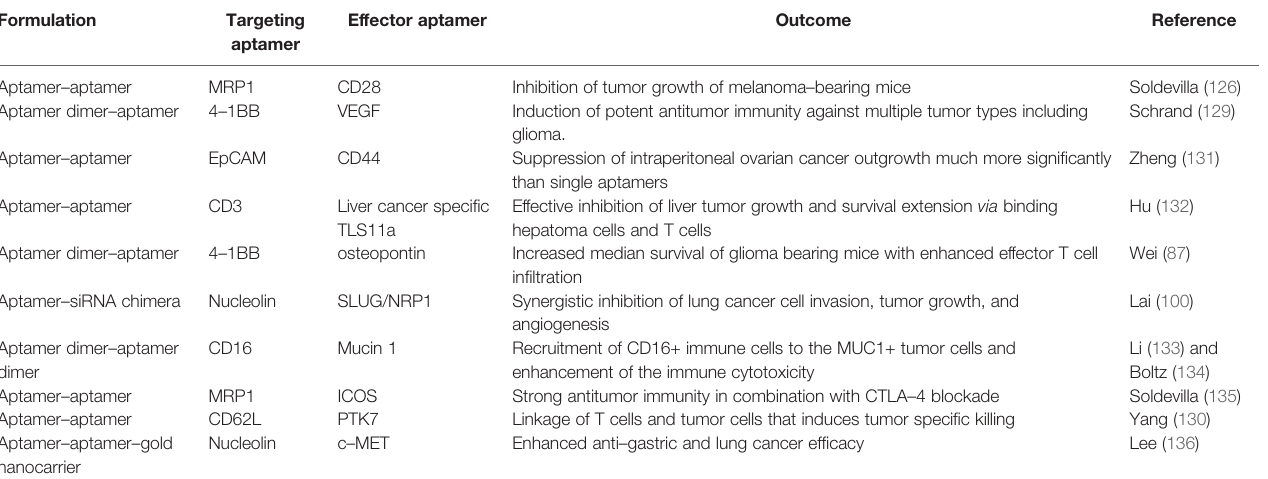
TABLE 2 | Summary of bispeci fi c aptamers applicable to the glioblastoma treatment.